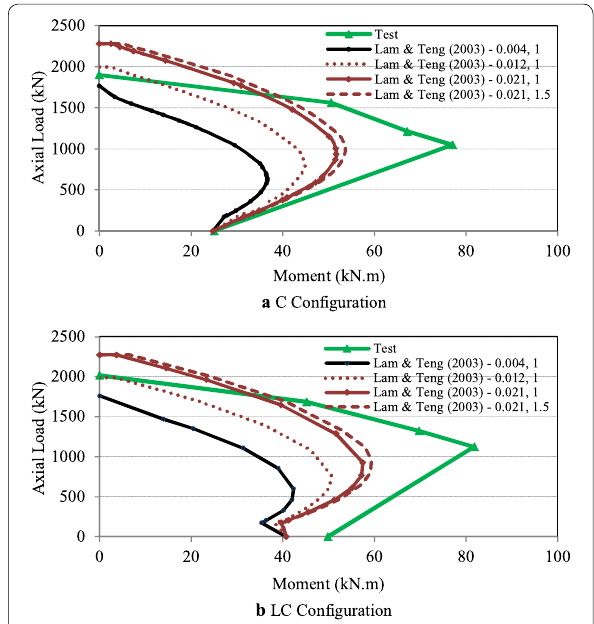
Fig. 10 Interaction diagrams for FRP‑jacketed columns obtained using Lam and Teng (2003) model for effective FRP strains of 0.004, 0.012 and 0.021; and UASR of 1 and